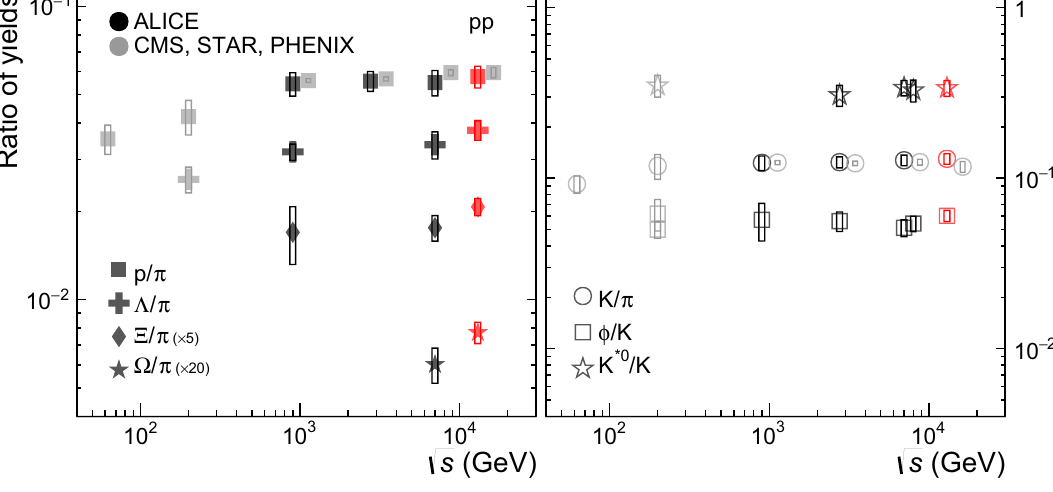
Fig. 11 Ratioofparticleyieldsto π ± andK ± asafunctionofthecolli- √ s (GeV). Results from ALICE [7,24,26,27,51,58,60,63] sion energy are compared with those from CMS [90] at the same energies, and with √ s = 200 GeV and PHENIX [19,20] those from STAR [88,91,92] at